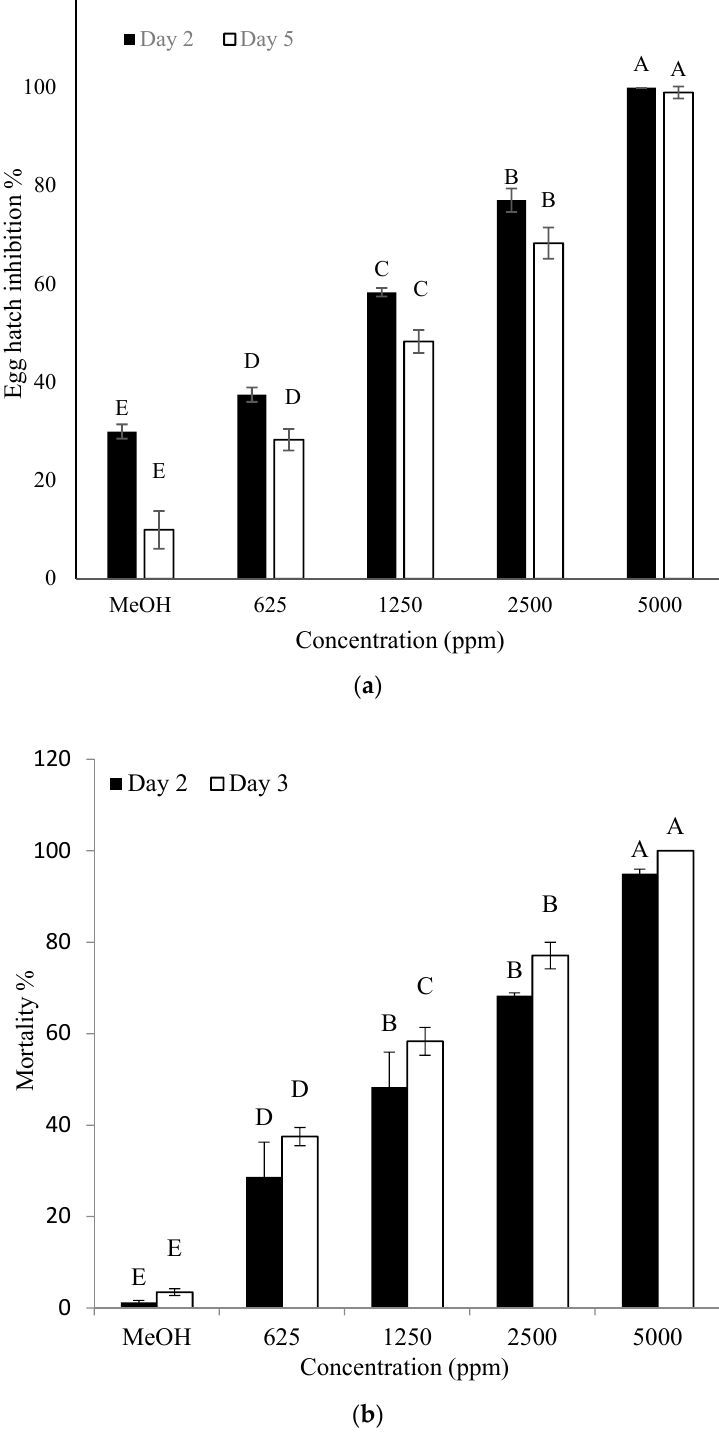
Figure 2. Effect of different concentrations of crude extract of strain Y1 on egg hatch ( a ) and second-stage juvenile (J2) mortality ( b ) of M. incognita at 26 °C for 2 and 5 days (eggs) and 1 and 3 days (J2) incubation. Methanol (MeOH) was used as control. Error bars represent standard error of the mean from three replicates. Means with the same letter in same observation time are not significantly different at p ≤ 0.05 when compared with LSD.